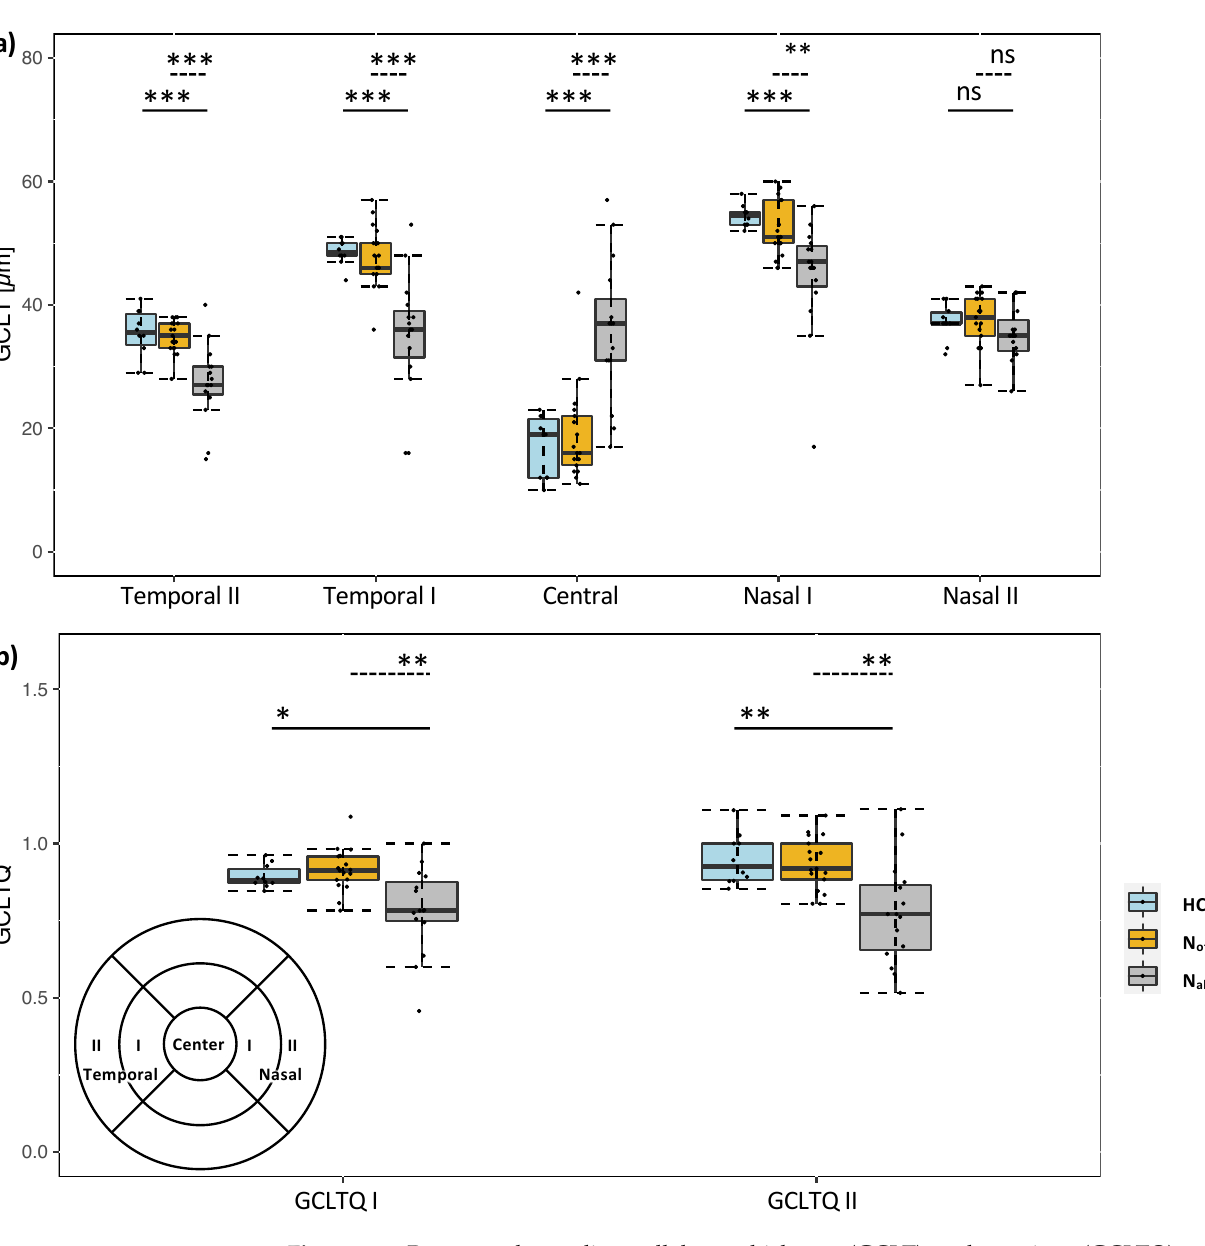
Figure 1. Paracentral ganglion cell layer thickness (GCLT) and quotient (GCLTQ) analysis. ( a ) Comparison of the GCLT in the 5 relevant sectors within the ETDRS macular OCT scan for healthy (HC) vs. albinism (N albinism ) and other causes of nystagmus (N other ). ( b ) Group comparisons of the GCLT quotients (GCLTQs) of temporal to nasal quadrants within the 3 mm macular ETDRS ring, i.e., GCLTQ I, and the outer 6 mm ring, i.e., GCLTQ II. Lower left panel is the ETDRS scan layout with areas of interest. p values were corrected after Sidak. * p < 0.05; ** p < 0.01; *** p < 0.0001. ns = non-significant p